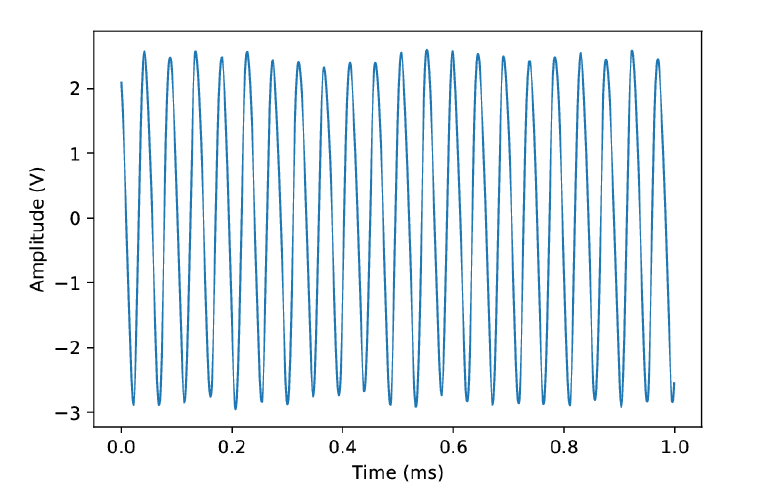
Figure 14. Sensor 2 output for the SO-3 turbojet at the takeoff